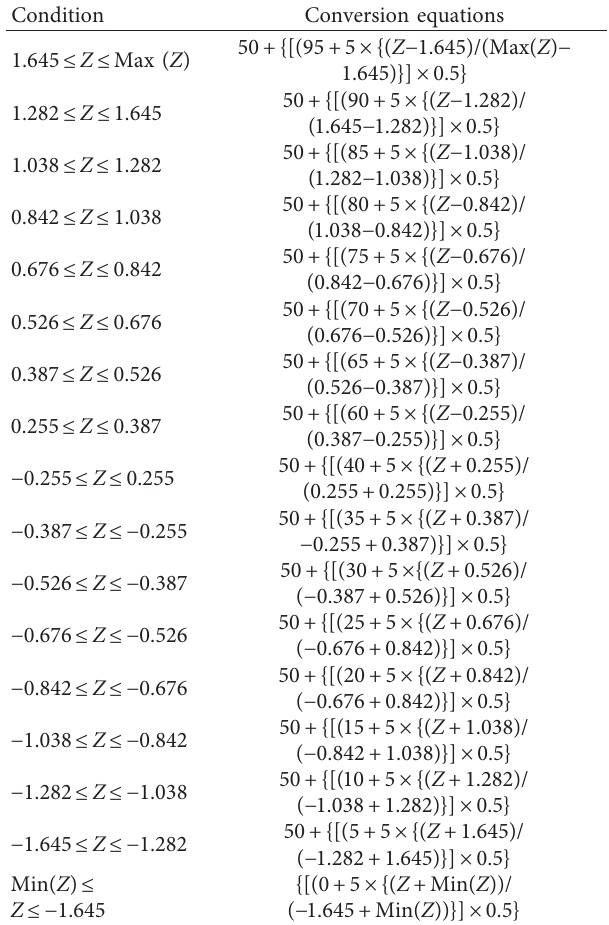
Table 1: Equations for converting the road conditions into a 100- point scale.